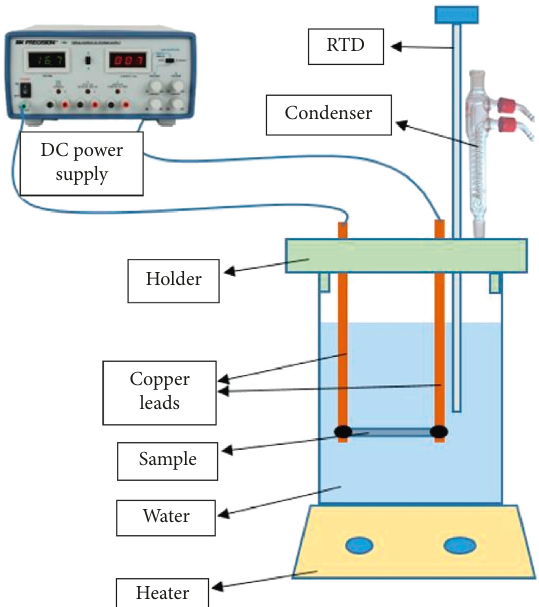
Figure 2: A schematic diagram of the boiling